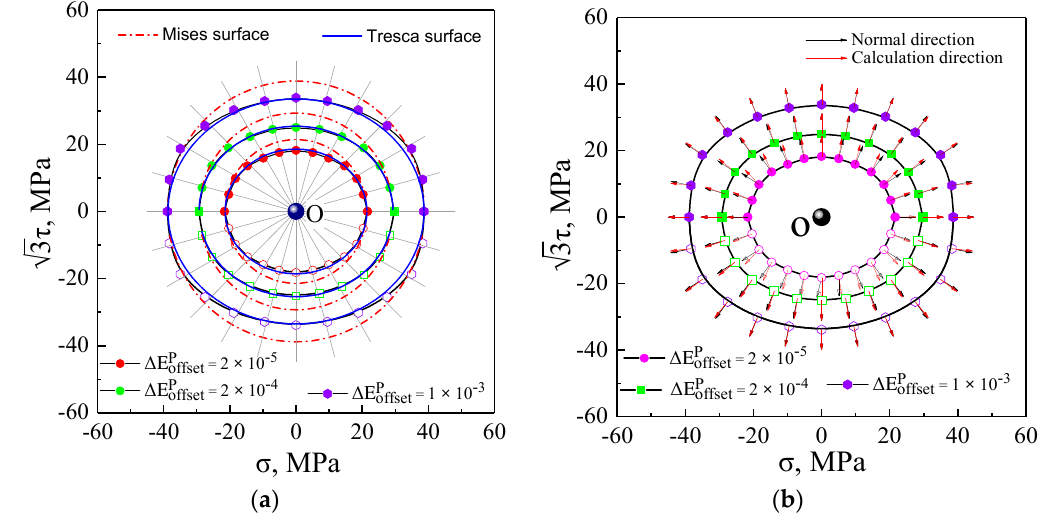
Figure 9. Initial yield surface by crystal plasticity simulation: ( a ) initial yield surfaces; ( b ) plastic flow directions.